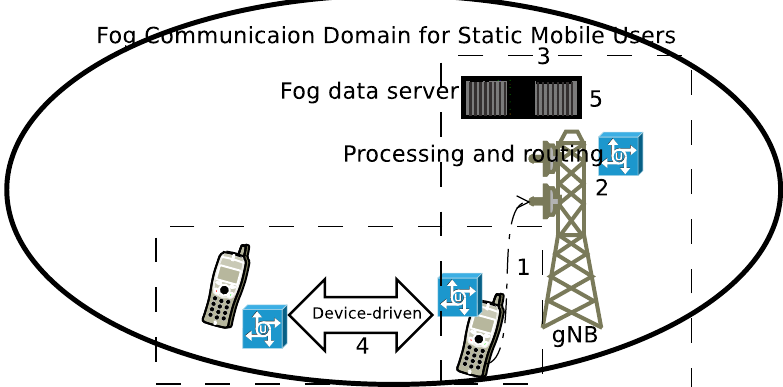
Figure 3. Fog network architecture for static mobile users. The nodes are using device-driven communication in the static